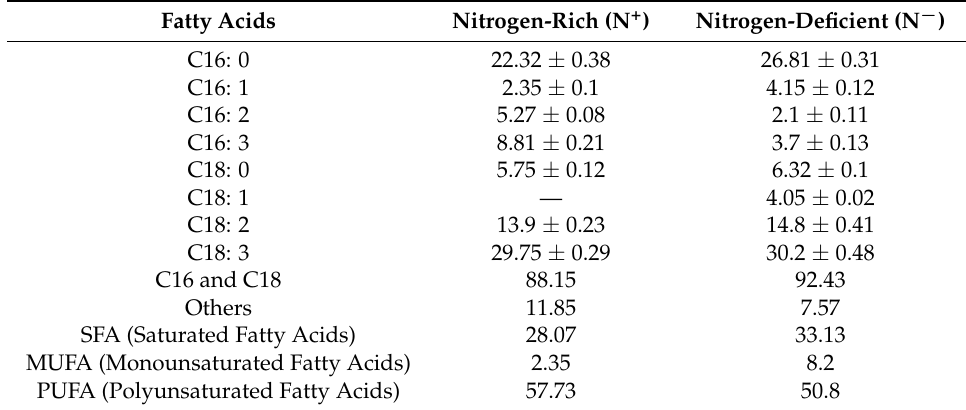
Table 1. Fatty acids profiles (percentage of total fatty acids) in Parachlorella kessleri TY02 under N + and N − culture conditions.